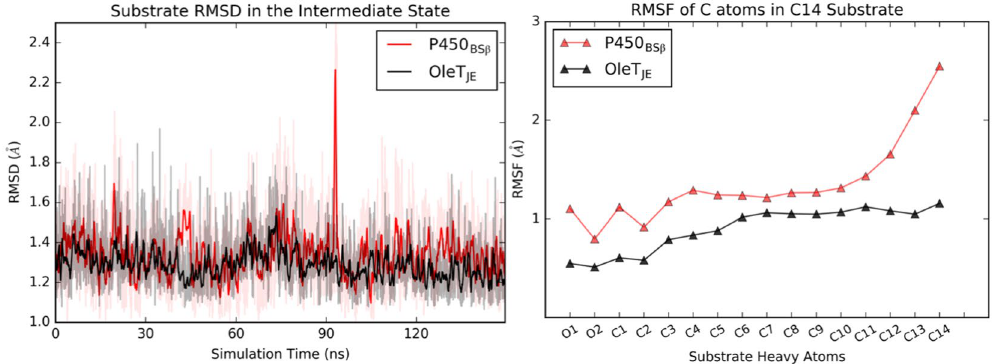
Figure 4. Substrate dynamics in the intermediate state: (Left) Trends for the Root Mean Square Deviations of the substrate center of mass over the 150 ns simulation trajectory. The darker lines depict the moving average for the RMSD value while the light regions indicate instantaneous values. (Right) Comparison of the flexibility of substrate oxygen and carbon atoms- C1 indicates the carboxylate Carbon and C14 the terminal carbon on the substrate tail. Values for P450 BS β are indicated in red and for OleT JE in black.